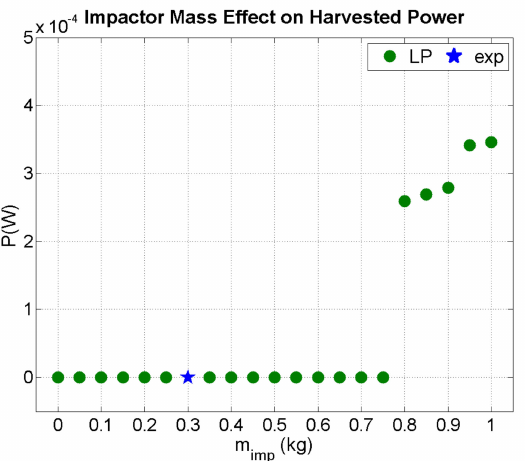
Figure 13. Predicted output power as a function of impactor mass (v i = 0.75 m/s).